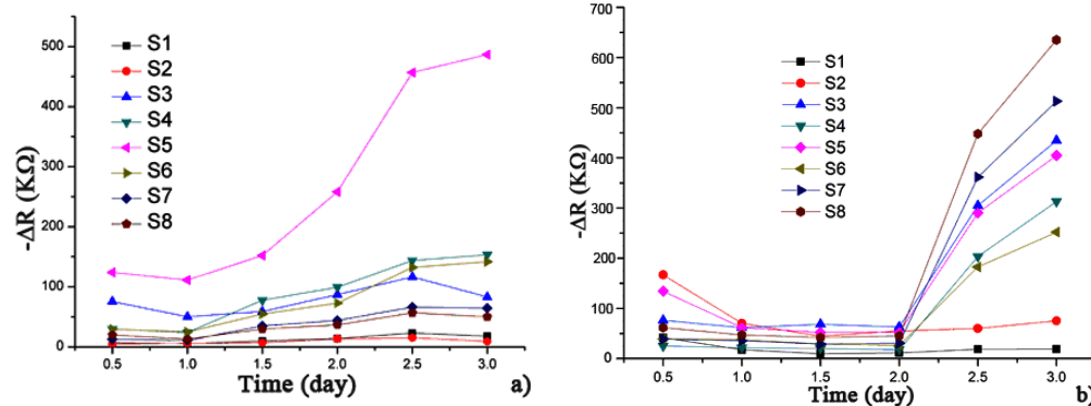
Figure 3. Time responses of the electronic nose for three days for hairtail fish ( a ) and pork ( b